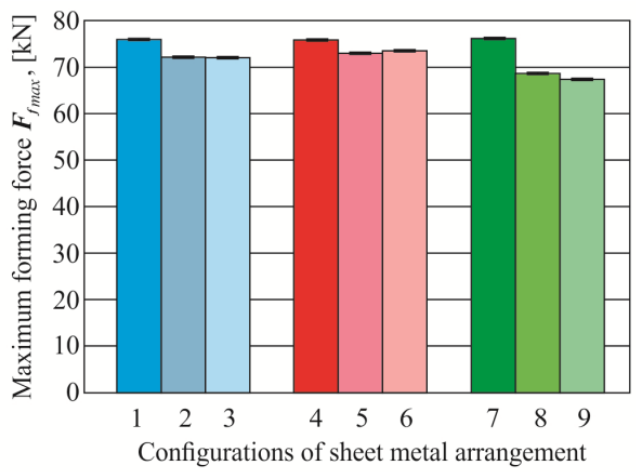
Figure 10. The average values of maximum joint forming force. Additionally, a comparative analysis of the registered characteristics of the joints’ forming force was performed for the sheet material arrangements (Figure 11). Three curves were compiled on separate charts, respectively, for each group of material arrangement of the upper and lower plates (as in Table 2). Depending on the AW 5754 state and the change in the arrangement of the sheet material, different diagrams of the forming force were obtained. The initial linear part resulted from the compliance characteristics of the forming tools. Significant differences in the course of the curves were observed for the value of the displacement index ( s i / s tot ) from 0.25 to 0.55 (Figure 11). The rivet was pressed into the materials until the lower metal sheet touched the bottom of the die (Figure 12a–c). Subsequently, further pressure of the punch on the rivet caused its upsetting and the flow of material in the radial direction (Figure 12b). The initial plastic flow of the material (with the simultaneous slight rotation of the moving segments) caused a local decrease in the forming force (detail “2” in Figure 13). Further pressing of the rivet caused the deformed sheet material to be pushed outside the die (between fixed segments), until the displacement index of about 0.55 was reached (Figure 11). Further pressing caused the rivet material and the sheets to flow between the fixed segments (Figure 12c), but with ever-greater force (the movable segments rotated and allowed the material to flow). At this stage, until the maximum displacement of the punch was achieved, the rivet and the sheets to be joined were interlocked. A similar material flow mechanism during the joint formation for self-piercing riveting technology has been described by Haque et al. [37]. It should be noted that when using CR technology, a die with movable segments is used. In the SPR technology, there is no such intense radial movement of the sheet material as in the case of forming of the CR joint. Due to the deformation of the rivet (rivet upsetting), the material of the joined sheets is forced to flow. As a result, an interlock is formed. In